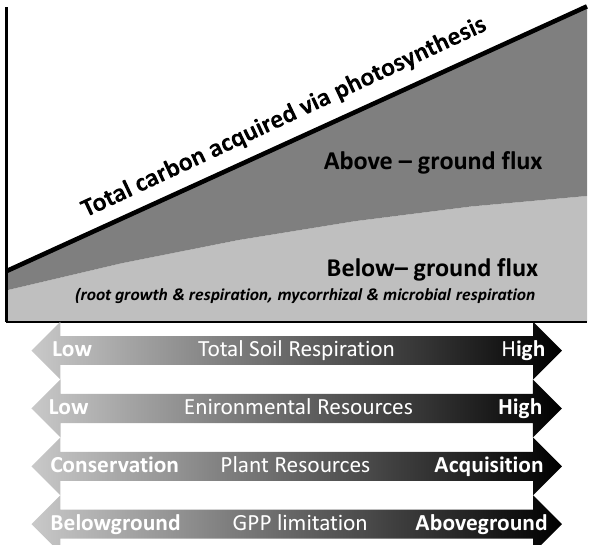
Figure 4. Hypothesized relationships between GPP partitioning and soil respiration, abiotic factors, plant functional type and limitations to photosynthesis. Modified from Litton and Giardina (2008).